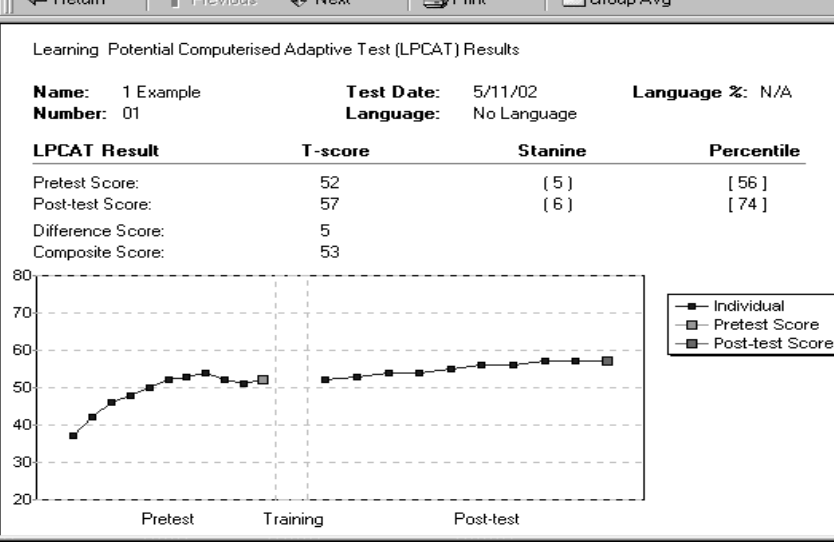
Figure 1: Example of LPCAT results